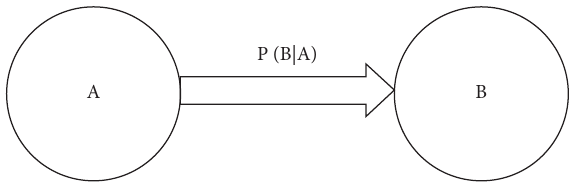
Figure 2: Simple form of Bayesian connection and conditional probability